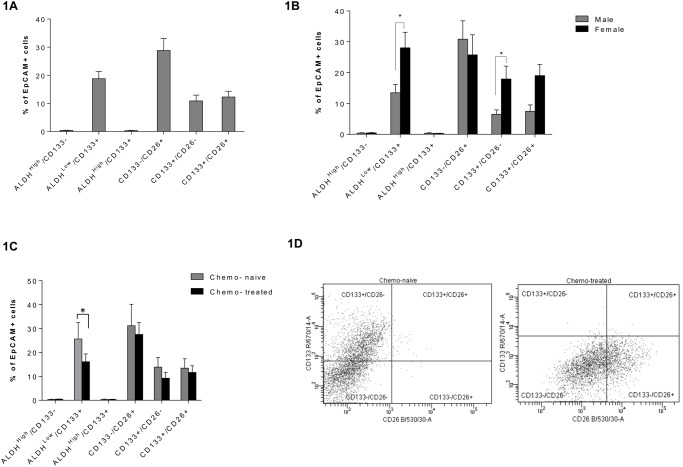
TIC marker expression in colorectal liver metastases.(A) Shows mean (±SEM) expression of TIC markers analysed by flow cytometry from patients undergoing resection for CRLM. N = 62 for ALDH combinations, N = 44 for CD26 combinations. (B) Mean (±SEM) TIC marker expression comparing males vs females. Male N = 39 and 26 for ALDH and CD26 combinations respectively, female N = 22 and 17 for ALDH and CD26 combinations respectively (independent t-tests, * = P≤0.05). (C) TIC marker expression in EpCAM+ cells stratified based on patient chemotherapy status. Chemo naïve N = 14, chemo-treated N = 36. (mean ± SEM, Mann Whitney-U test, * indicates P = 0.05). (D) Representative dot plot for CD26 (x-axis) and CD133 (y-axis) in a chemo-naïve (left) and chemo-treated (right) patient.